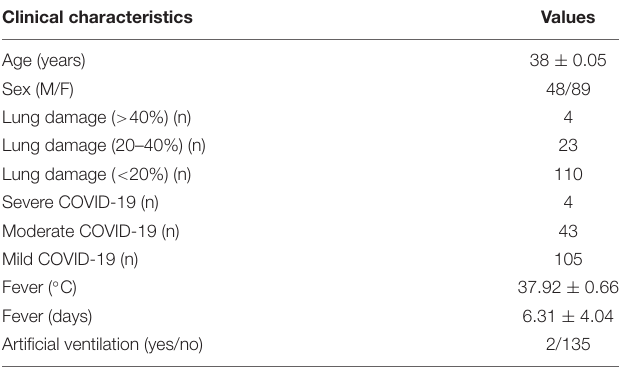
TABLE 1 | Clinical characteristics of acute and convalescent COVID-19